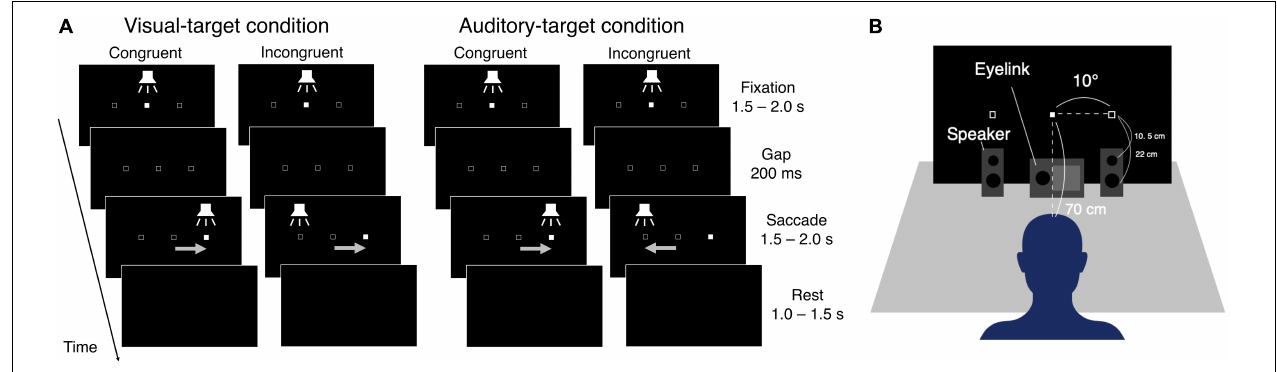
FIGURE 1 | (A) Schematic representation of the saccade tasks. Visual- and auditory-target conditions were conducted in separate blocks. First, the visual and auditory stimuli were presented at the center position (Fixation period). The visual stimulus was a filled square (1 ◦ on each side). The auditory stimulus was white noise. The visual stimulus was changed to an empty square, and the auditory stimulus disappeared for a period of 200 ms (Gap period), followed by the appearance of the visual or auditory stimuli at one of the peripheral positions (Saccade period). For the saccade period, congruent or incongruent trials occurred randomly. After the Saccade period, all stimuli disappeared (Rest period). (B) Experiment